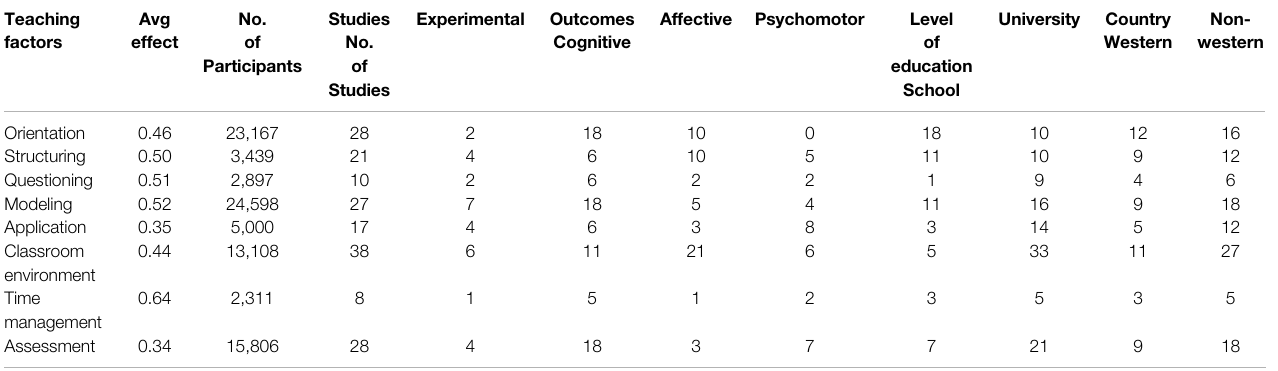
TABLE 3 | Characteristics of studies investigating the effect of teacher-level factors on student achievement and types of effects identi fi ed.